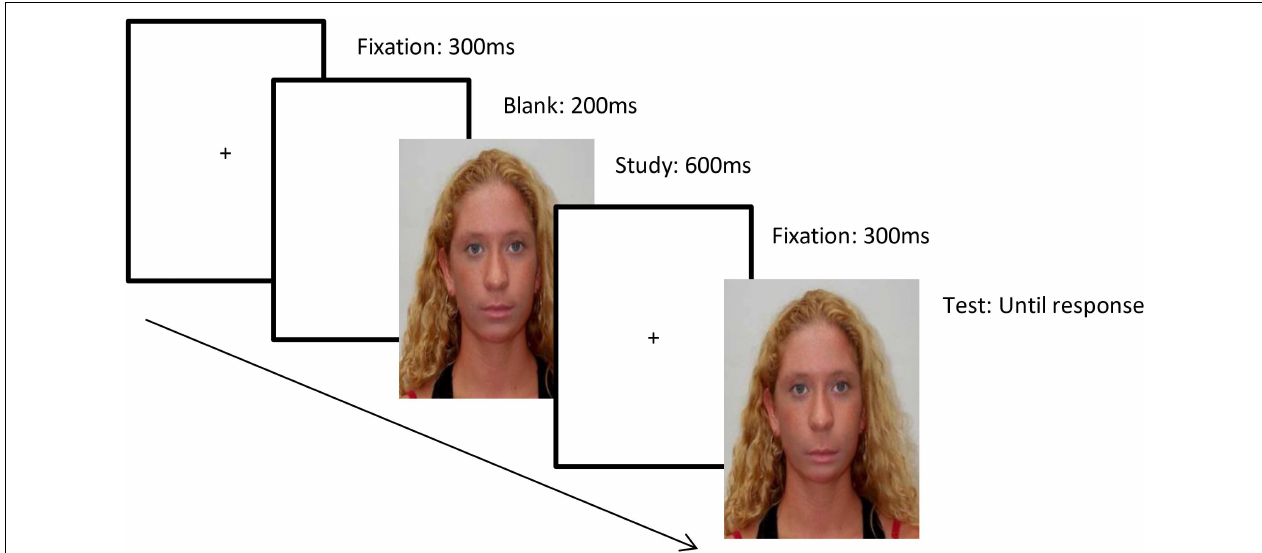
FIGURE 4 | An example of a trial. In this example the top halves of the two faces are the same but the bottom halves are different. The correct response would be ‘same’ for Experiment 1.